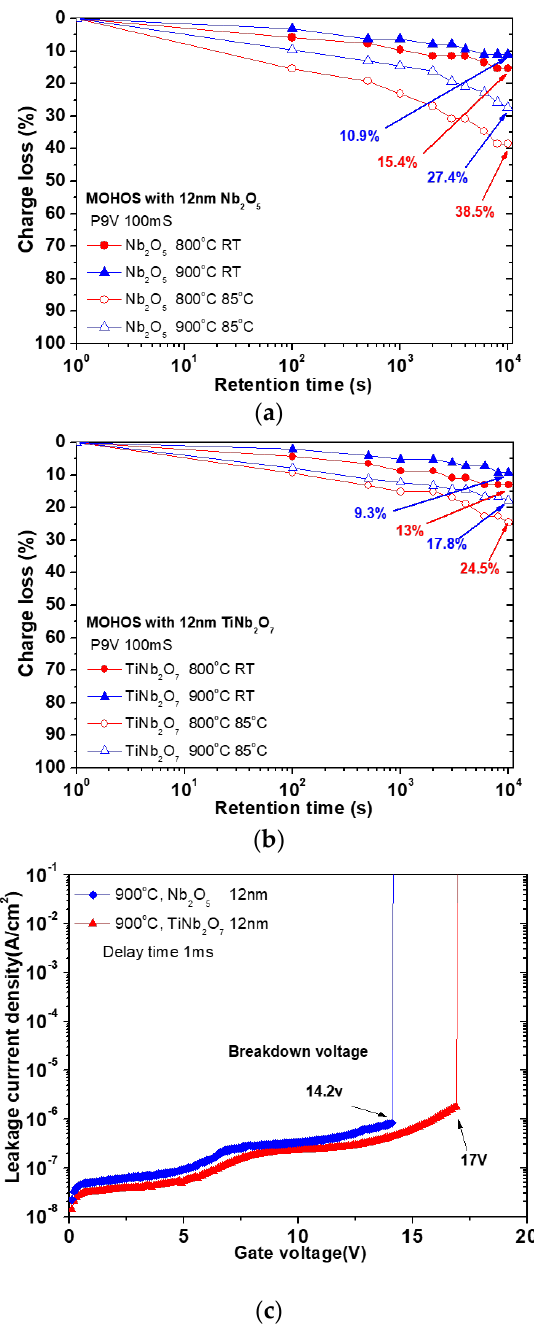
Figure 4. Data retention of the ( a ) Nb 2 O 5 and ( b ) TiNb 2 O 7 charge-trapping nano-layers measured at RT and 85 °C; ( c ) the leakage current density versus gate voltage of the Nb 2 O 5 and TiNb 2 O 7 trapping nano-layers for the top gate applied a positive bias.